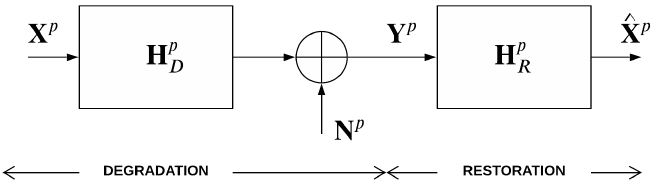
Figure 2. A general block diagram representing degradation and restoration